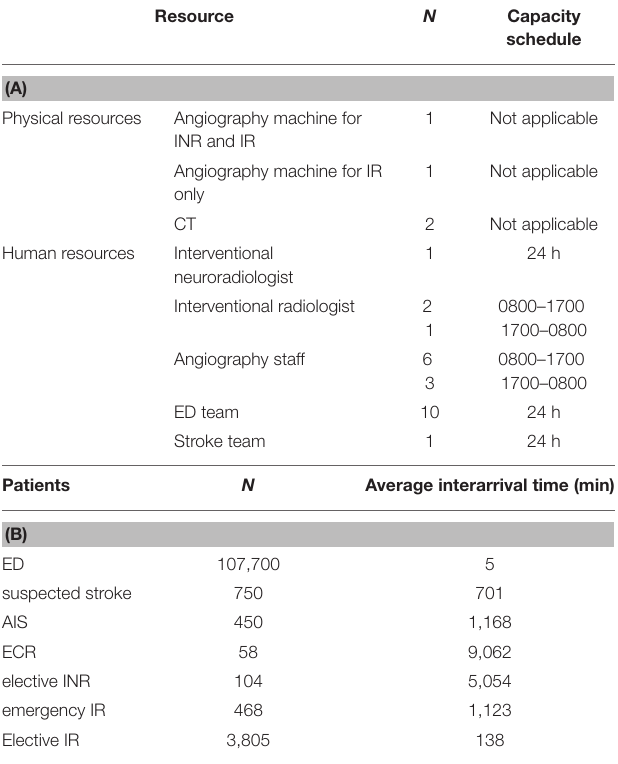
TABLE 1 | DES model